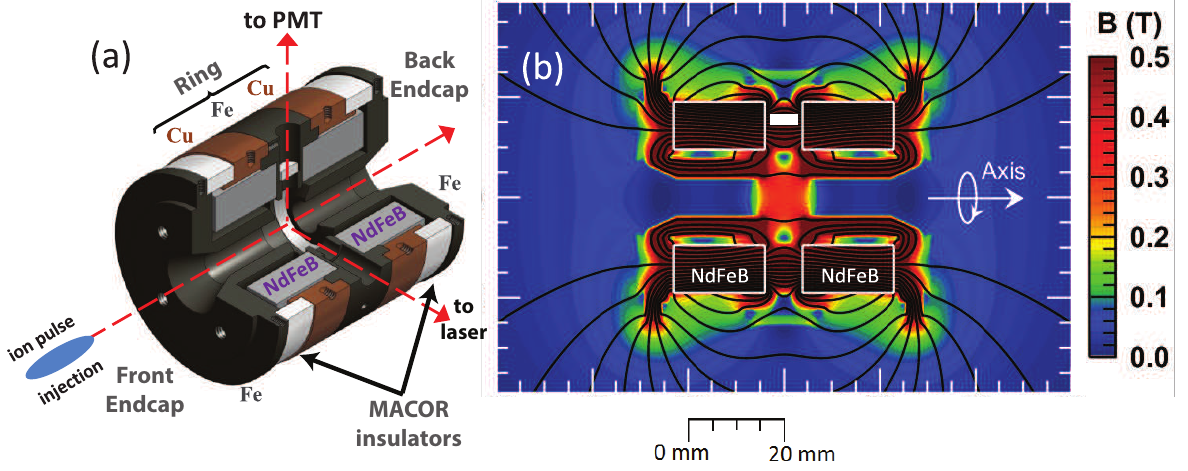
Figure 3. ( a ) A quarter-cut three-dimensional representation of a two-magnet unitary Penning trap. Ions are injected in pulses along the symmetry axis, with laser and photomultiplier (PMT) access perpendicular; ( b ) magnetic flux density for the unitary Penning trap illustrated on the left. The magnetic field is produced by two axially-magnetized NdFeB magnets with an internal flux density as high as ≈ 1 . 2 T. Colors indicate equal magnetic flux density contours (full scale is arbitrarily set at 0.5 T to highlight the trapping